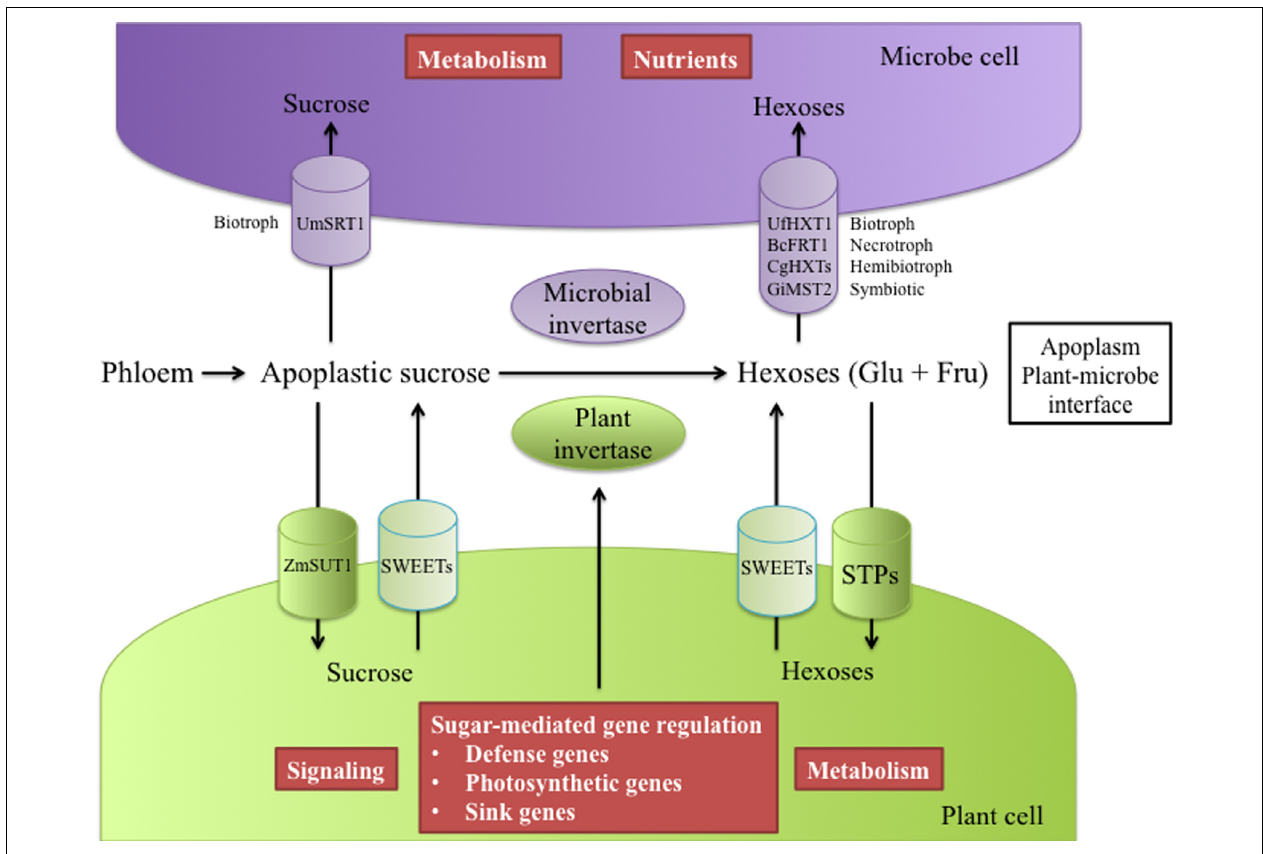
GiMST2).To gain access to apoplastic hexoses, plants possess a large repertoire of STPs that can support host demand. Multiple roles of hexoses in host cells have been described; among others, hexoses can be used as an energy source or as signaling molecules and regulators of pathogenesis-related, photosynthetic and sink gene expression. An indirect consequence of host sucrose and hexose acquisition is a possible starvation of microbes through a limited access to sugar at the interface. Host sugar uptake can be bypassed in some pathogenic interactions. Specific effectors (not represented in the diagram) released by some bacteria and probably fungi can manipulate host sugar effluxers (SWEETs) and further